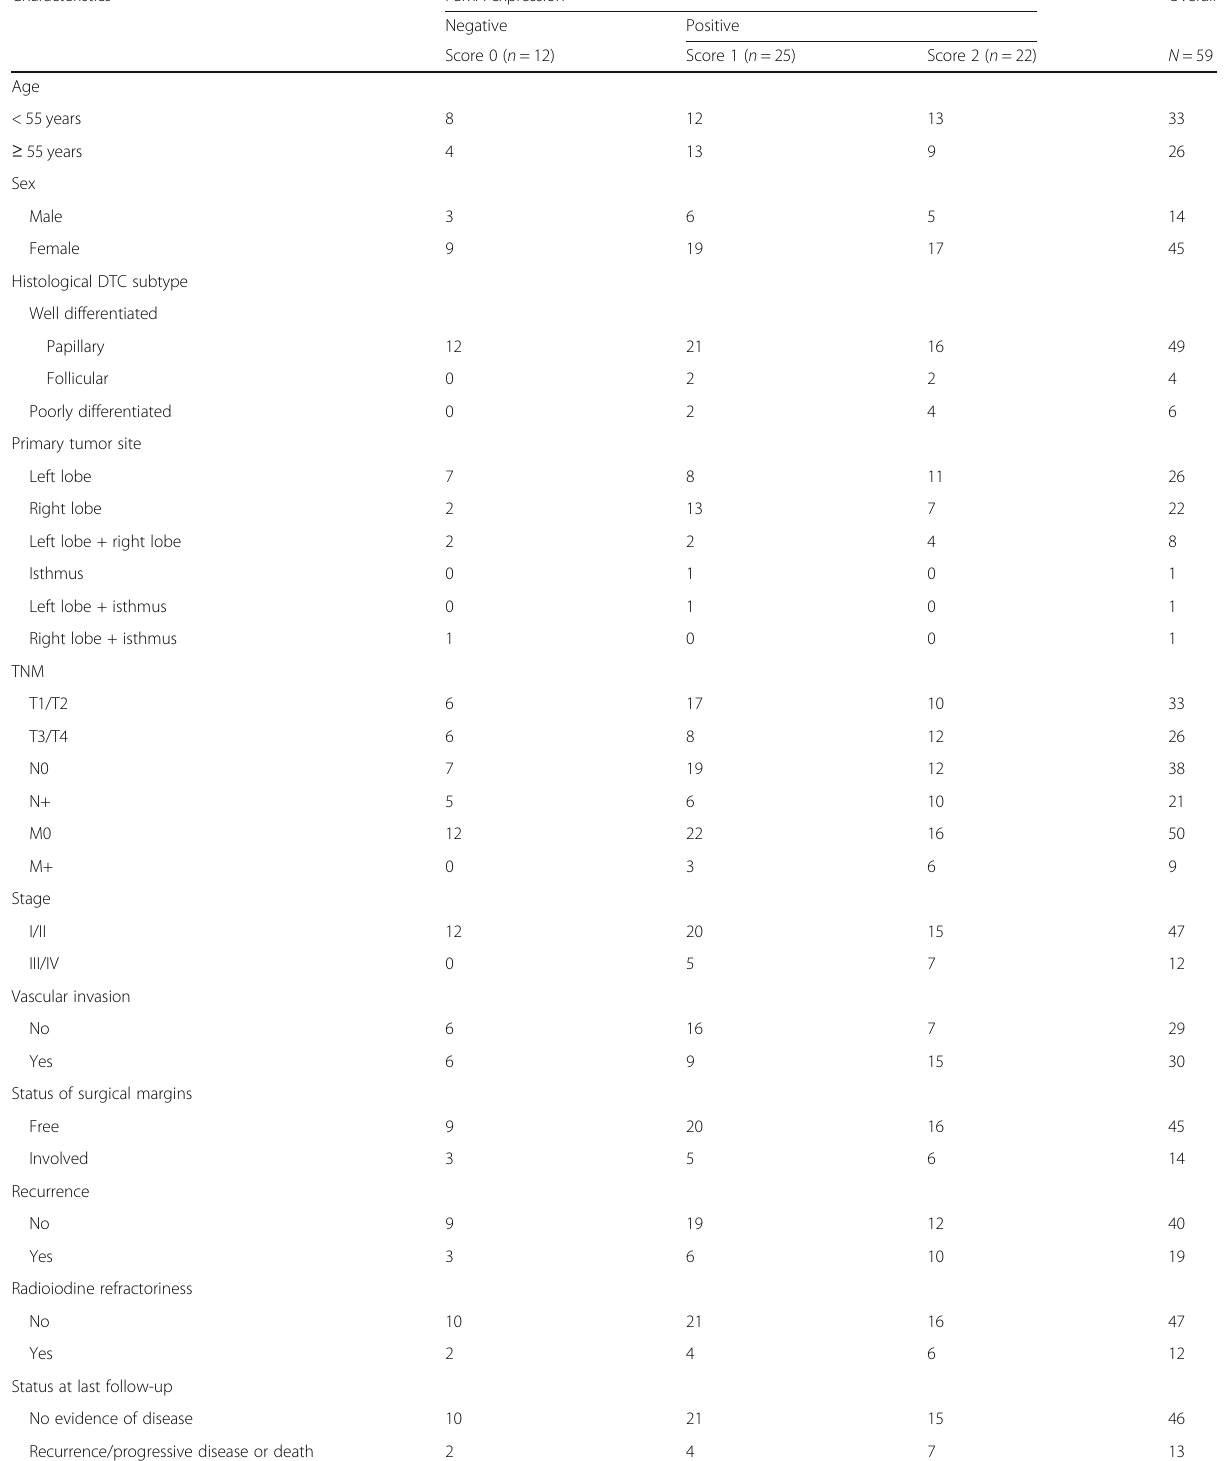
Table 1 Baseline patients ’